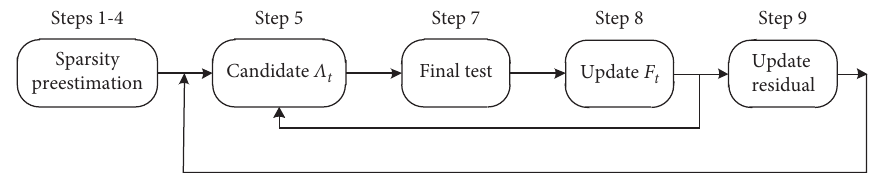
Figure 1: Flowchart of the proposed SPAMP algorithm.